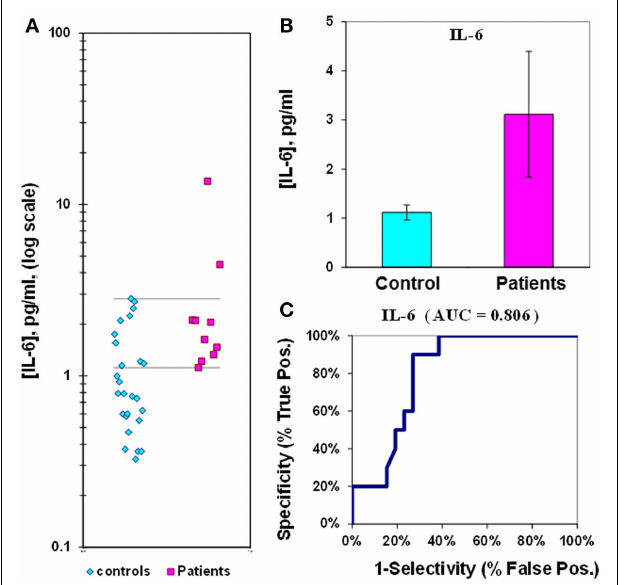
FIGURE 2 |Assay of IL-6 in plasma from epilepsy patients and controls. (A) Dot-plot of IL-6 concentrations in plasma (square, patients; diamond, controls). For values between the horizontal lines, the assay does not accurately discriminate between patients and controls. (B) Bar graph and error calculation for data in Part (A) . Difference is not significant for p = 0.067. (C) ROC curve for data in Part a, showing an area under the curve (AUC) value of 0.81.